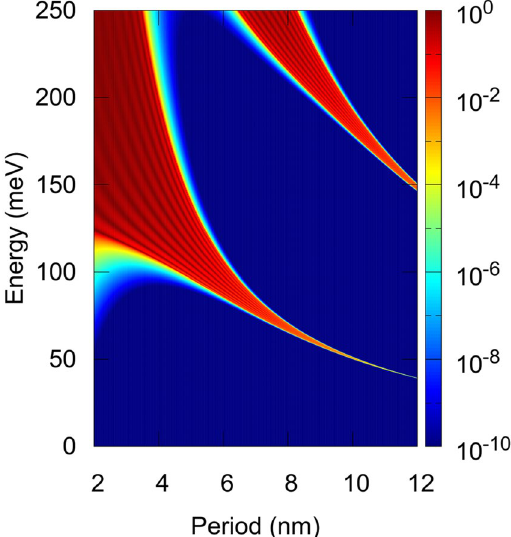
Figure 6. Transmission coefficient for electrons below the GaAs bandgap energy as a function of the period thickness. Contour plot of the electron transmission coefficient for a 12 barrier/quantum well array as a function of period thickness between 2 and 12 nm. The height of the barrier is 250 meV and the effective mass 0.146 m 0 , which are the parameters used to model the SL-II sample in Fig. 4b. The color bar is in log scale. The formation of electronically coupled minibands for small periods becomes evident by the broadening of the high transmission coefficient